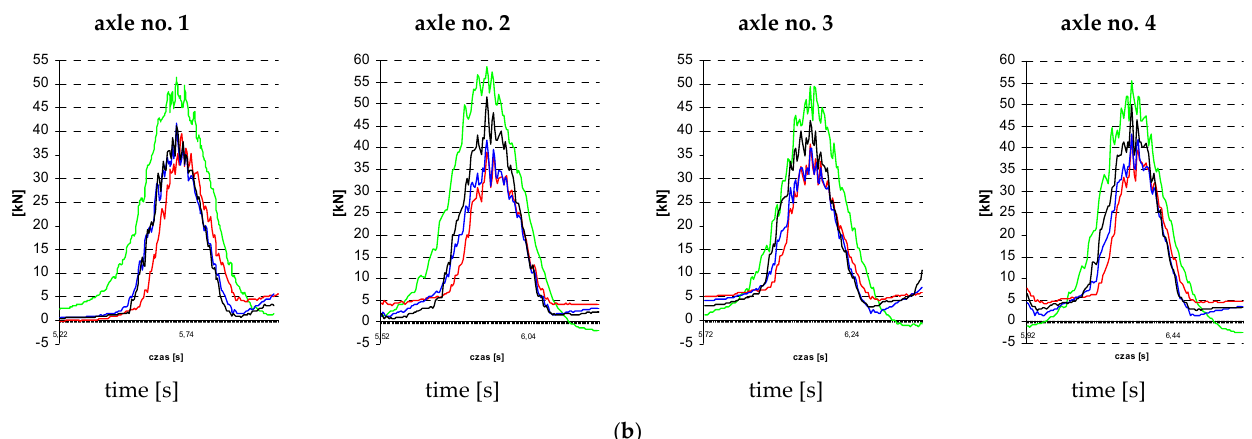
Figure 11. The force transferred from the rail to the sleeper due to the induced irregularity in the railway track for the scheme from Figure 3 (the loads from the locomotive’s succeeding axles): ( a ) a measurement by a force sensor in cross-section no. 2 (a record on the force sensor); ( b ) a measurement by a force sensor in cross-section no. 1. The changes in the value of the force transferred from the rail to the railway sleeper are visible as a consequence of changes in the deflections of the rail and sleeper, as well as the stresses in the rail foot, as shown in Figure 12.